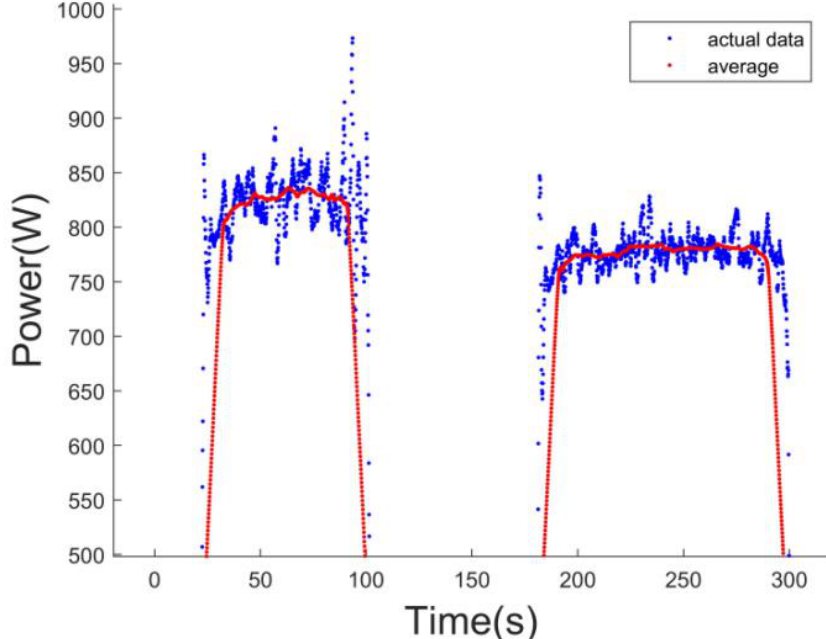
Figure 16. The output control quantity at preparation state and flight state. The total robot power is shown in Figure 17. We also performed the mean filtering with n = 200 (as shown in the red line). The total robot hovering power is about 830 W when the robot is in the preparation state and about 780 W when the robot is in the flight state. The power difference is about 6%. If the robot works in the flight state, the working time of the robot can be extended. Taking a 6 s 5000 mah battery as an example, the robot working time can be extended from 481 s to 512 s.